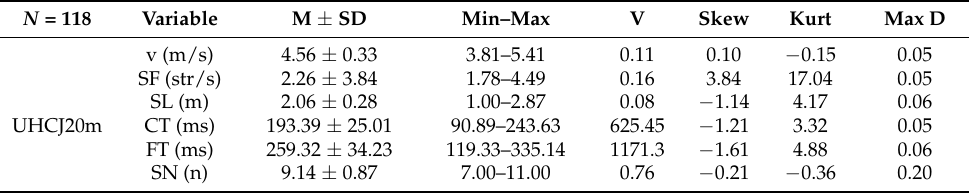
Table 3. Descriptive statistics of kinematic parameters of the UHCJ20m, MRLS20m, and MRFS20m